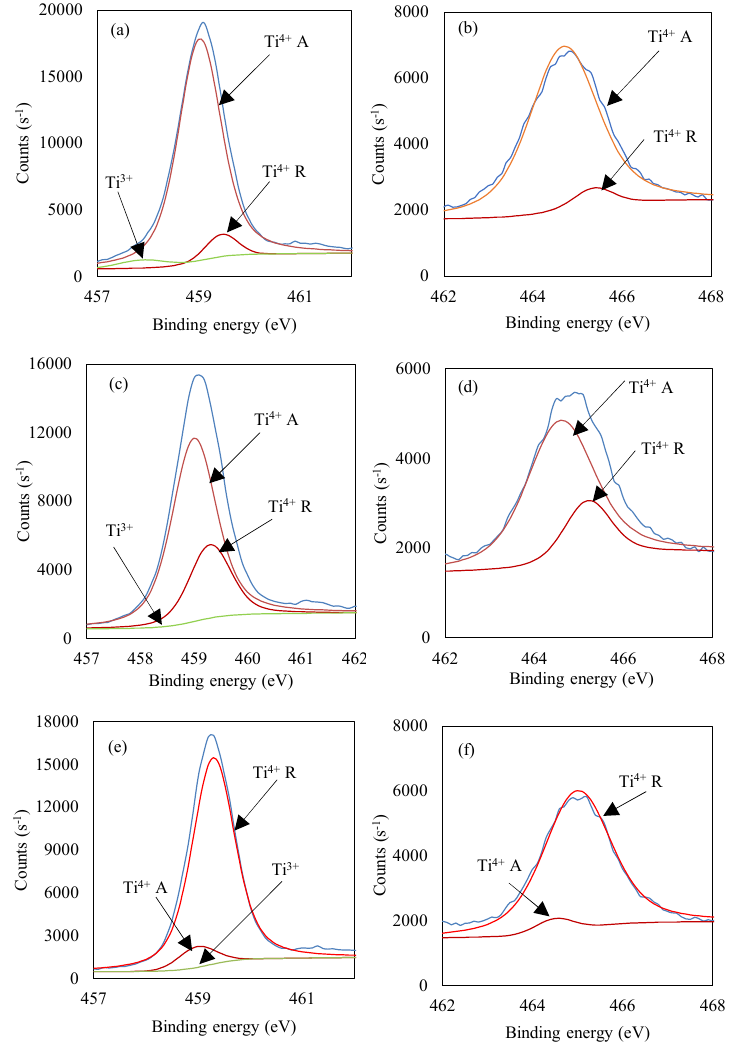
Figure 18. Deconvolution of X-ray photoelectron spectroscopy (XPS) spectra for Ti 2p 3/2 and 2p 1/2 for Table 9. Fraction of oxidation states of Ti as well as surface composition of selected